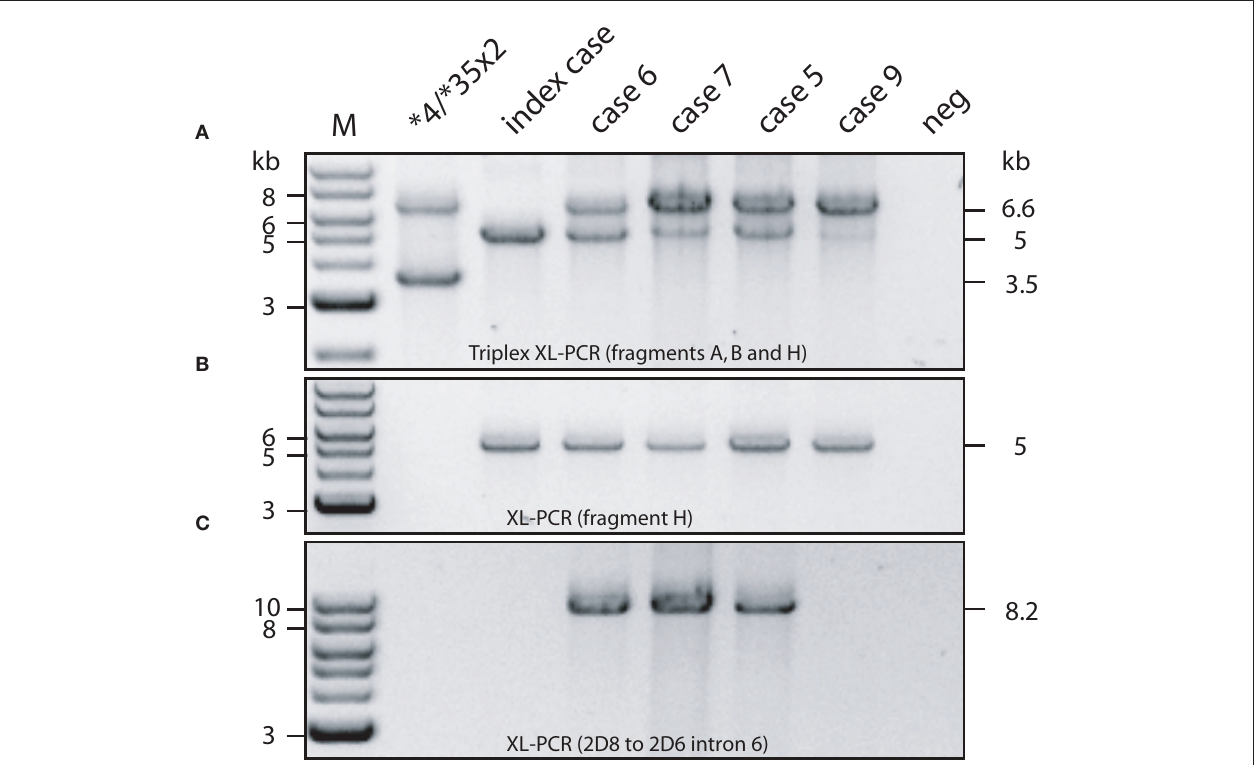
duplication), and fragment H (indicating the presence of a CYP2D7/2D6 hybrid gene). (B) Fragment H was generated by itself. Note that this fragment is weak in the triplex reaction in panel A for case 9, but unequivocally present when amplified “solo”. (C) As expected from sequence data, cases 5, 6, and 7 generated a